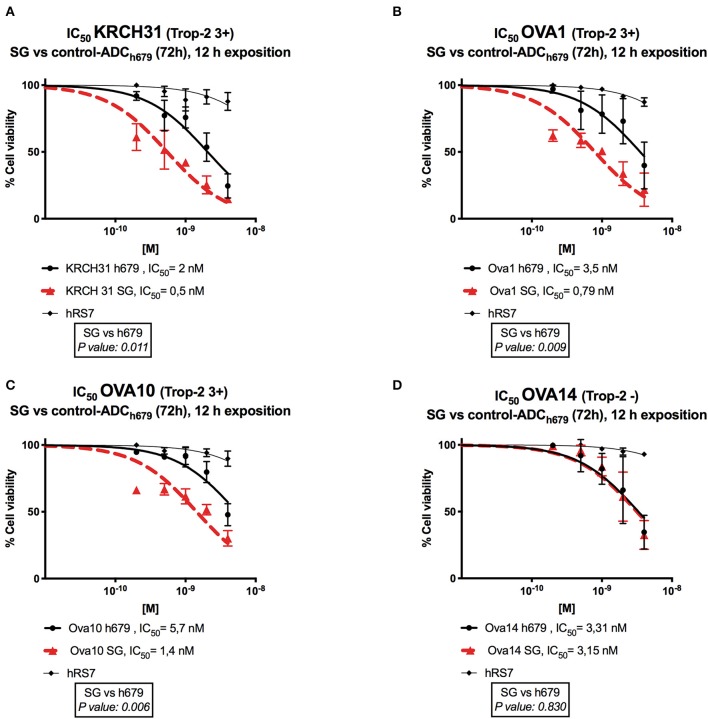
Determination by IC50 of SG cytotoxicity compared to controls, control ADC (h679-CL2A-SN-38) and hRS7 IgG in EOC. (A–C) EOC cell lines with high Trop-2 expression (3+) (i.e., KRCH31, OVA1, OVA10) demonstrated significantly lower IC50 when compared to control ADC (p < 0.05). (D) EOC cell line with low/negligible Trop-2 expression (i.e., OVA14) showed no difference in the IC50s of SG and control ADC. hRS7 antibody was inactive against all these cell lines.